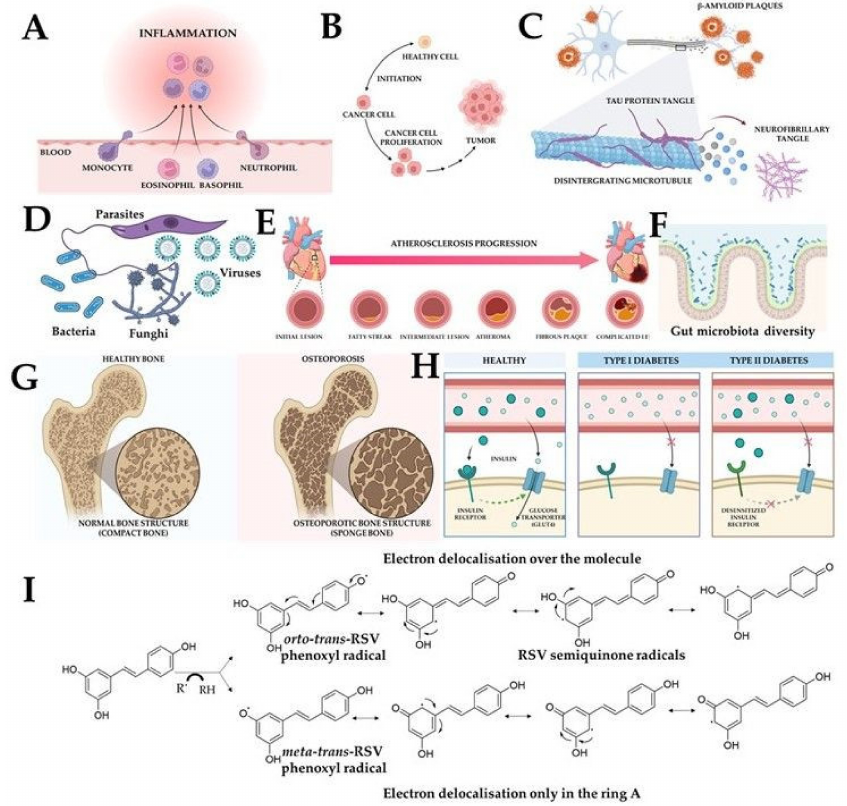
Figure 3. Pleiotropic activity of resveratrol molecule. Inflammation can be prevented by 3,4 (cid:48) ,5- trans -trihydroxystilbene ( A ); it inhibits cancer development in its three primary stages: initiation, promotion and progression of cancer ( B ); neurodegenerative diseases ( C ). It has antiviral, antibacterial, antifungal, and antiparasitic activity ( D ). It can decrease the risk of atherosclerosis, and coronary heart diseases ( E ). Resveratrol modulates gut microbiota diversity to increase gut permeability and the integrity of intestinal tight junction proteins and modulates bone mineralisation and muscular metabolism ( F ). Increases bone mineral density and volume, decreases risk of osteoporosis ( G ) Moreover, it has protective effects against metabolic disorders ( H ) and can act as an antioxidant ( I ) (modified from [34]). Created with